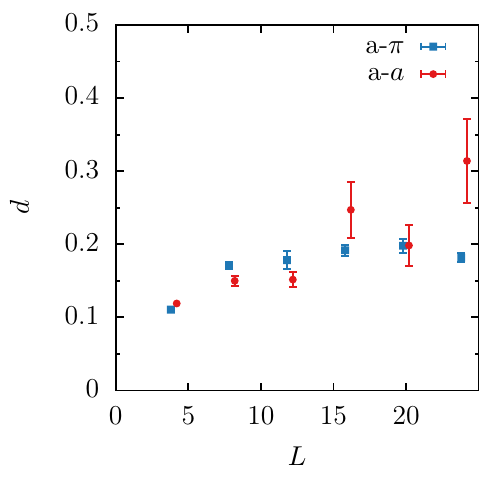
Figure 4 . Dominant mass contribution of a- π and a- a for different lattice sizes L 3 × 2 L with L ∈ { 4 , 8 , 12 , 16 , 20 , 24 } . The bare gluino mass is ( m, m 5 ) = ( -1.0506 , 0.0 ) and the lattice coupling β = 5.0. Points are slightly displaced for better